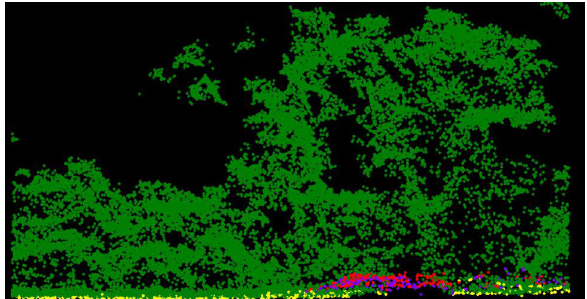
Figure 2 . Copan ALS survey 3D Classified Point